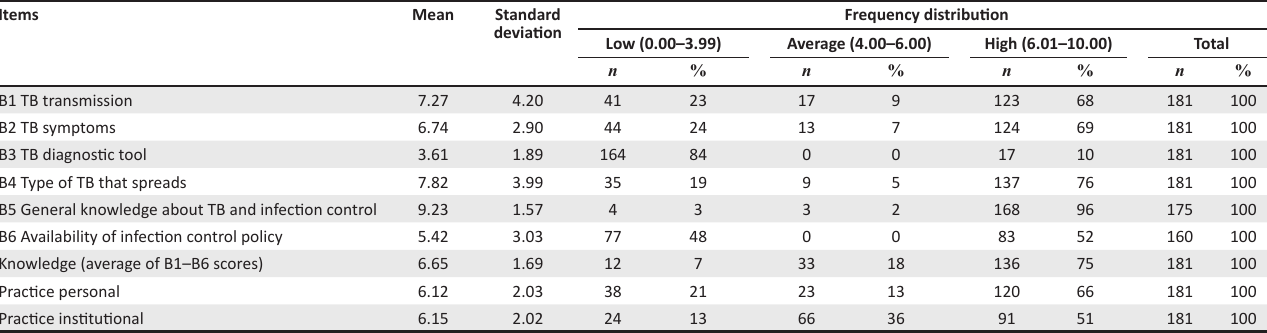
TABLE 4: Descriptive statistics – Knowledge and practice scores. Items Mean Standard